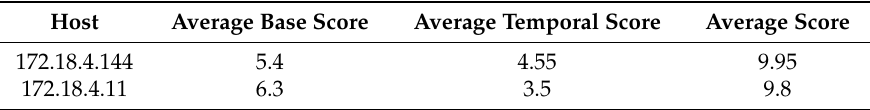
Table 4. Network Vulnerability